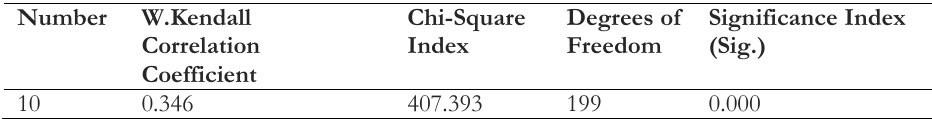
Table 2. W. Kendall correlation test (Delphi round two).